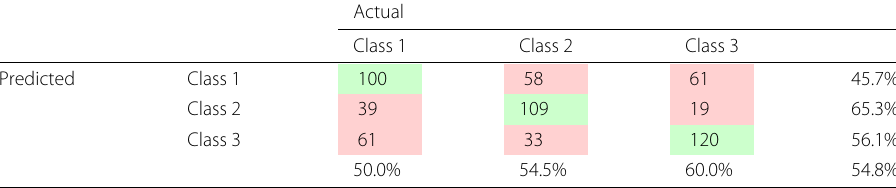
Table 6 Confusion matrix using features obtained with WV. Total classification accuracy is 54.8%